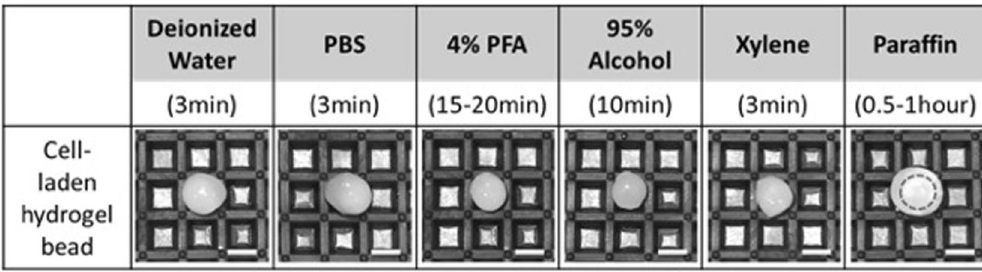
Figure 2. The change of cell-laden hydrogel bead for cell block formation after dipping in various solutions (Scale bar = 3